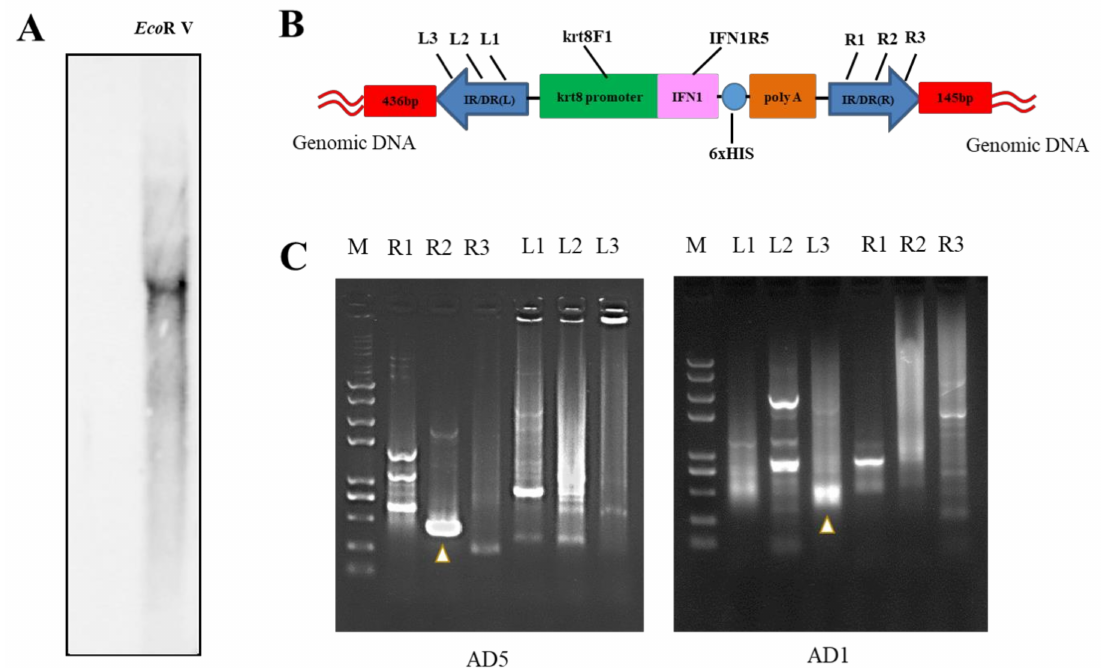
Figure 6. Analysis of integration site of IFN1-expressing cassette in transgenic loaches. ( A ) Genomic DNA of grass carp IFN1 cDNA-transgenic loaches was digested with Eco RV and subjected to Southern blotting with digoxigenin-labelled cDNA probes and antidigoxin antibodies. ( B ) Schematic diagram of the transposon-mediated IFN1-expressing cassette integrated in the genome, showing primer pairs krt8-F1/IFN1-R5 for Southern blots. ( C ) The electrophoresis of genome walking. AD5 and AD1 are merging primers for the genome of loach. R1, R2, R3 and L1, L2, L3 are primers designed on integrated IFN1-expressing cassette of the plasmid